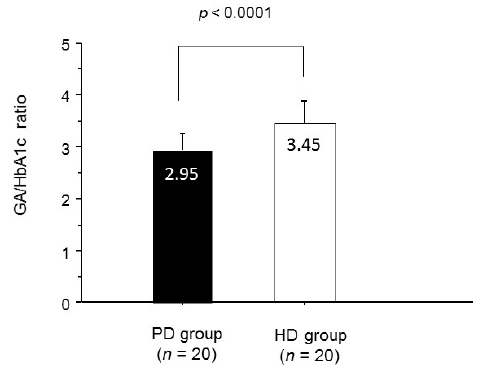
Figure 1. Comparison of glycated albumin (GA)/HbA1c ratio between the two groups.